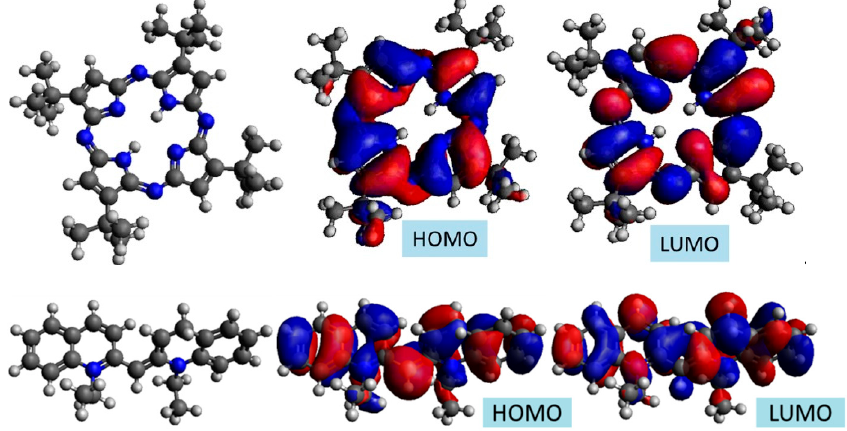
Figure 1. Electronic structure of the HOMO und LUMO of TAP ( top ) and PIC ( bottom ). Carbon atoms are depicted in black nitrogen in blue and hydrogen in white. For both molecules, the HOMO and LUMO extends over the whole conjugated system.